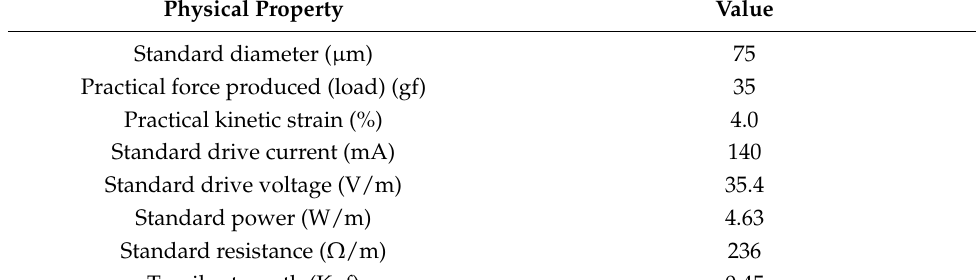
Figure 5. Sliding the SMA sensor on material surface.